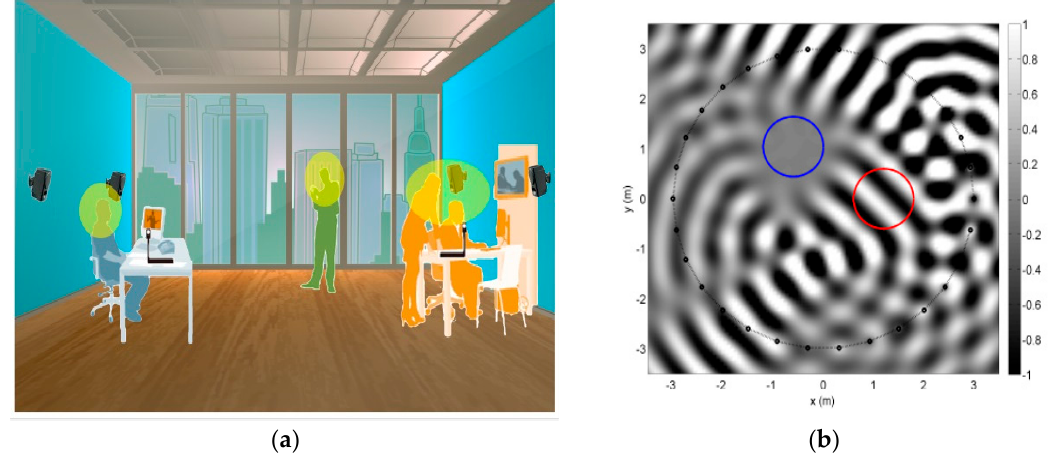
Figure 5. ( a ) an illustration of multi-zone sound reproduction in an office environment; ( b ) a plane wave of 500 Hz from 45° is reproduced in the bright zone (red circle) with a dark or quiet zone (blue circle) generated using a circular array of 30 loudspeakers [134].